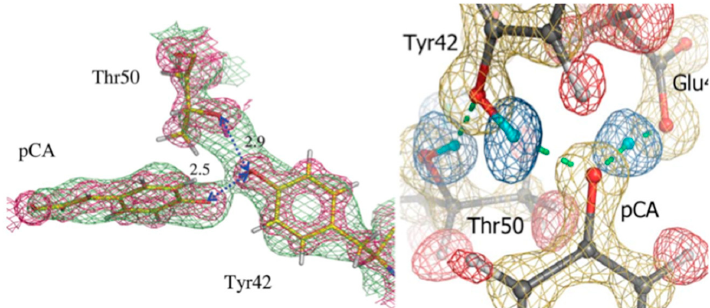
Figure 5. Nuclear density maps around the pCA of PYP. ( Left ) H bonds around the pCA in PYP as observed in the 2.5 Å structure [29]. Reproduced with permission from the International Union of Crystallography; ( Right ) High resolution neutron studies to 1.5 Å enable accurate determination of H/D atom positions and assignment of LBHB in PYP. Figure reproduced from [28].